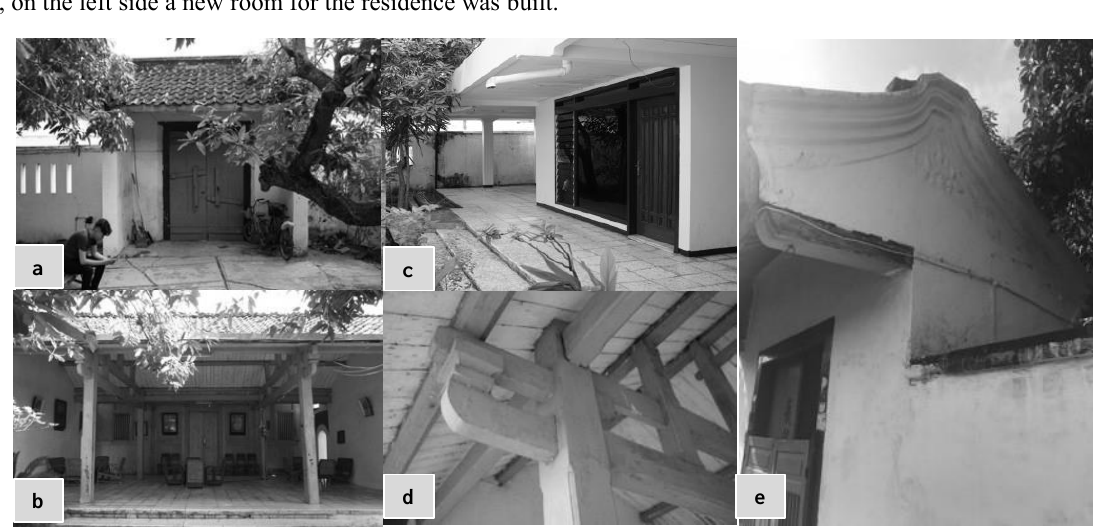
Figure 9. The Chinese architectural features: (a) the main gate with the gable wall, (b) the verandah with wood frame structure, (c) the addition of new building for residence, (d) Dou gong wood construction system at the verandah, and (e) the gable wall of the main gate